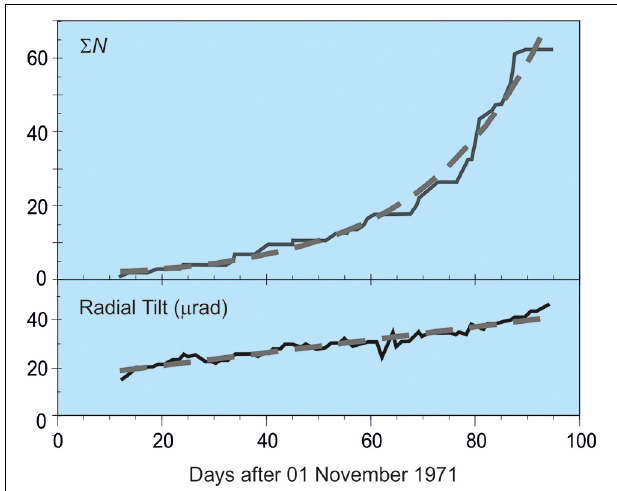
FIGURE 3 | The number of VT events may accelerate with time ( top ), while the mean deformation rate remains constant ( bottom , gradient of broken line). The example shows VT and deformation trends before the flank eruption of Mauna Ulu on Kilauea, Hawaii, on 04 February 1972 (most VT events had magnitudes between 1.5 and 4; Bell and Kilburn, 2011). In this case, the VT number, (cid:54) N , increases exponentially with time t (in days; broken curve ) as 1.17 exp ( t /23.3); the mean daily VT event rate increases 0.05 exp ( t /23.3). The combination of exponential VT rate and constant deformation rate is consistent with quasi-elastic brittle behavior under a constant rate of stress supply ( Table 1 ). The eruption occurred almost immediately after the end of the quasi-elastic regime when t /23.3 ≈